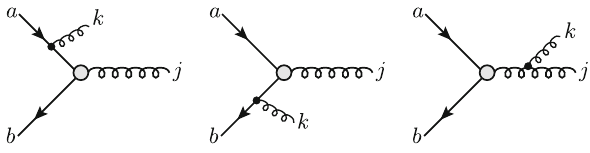
Fig. 2 Feynman diagrams for the emission of one gluon off the three- hard-partons configuration ( abj